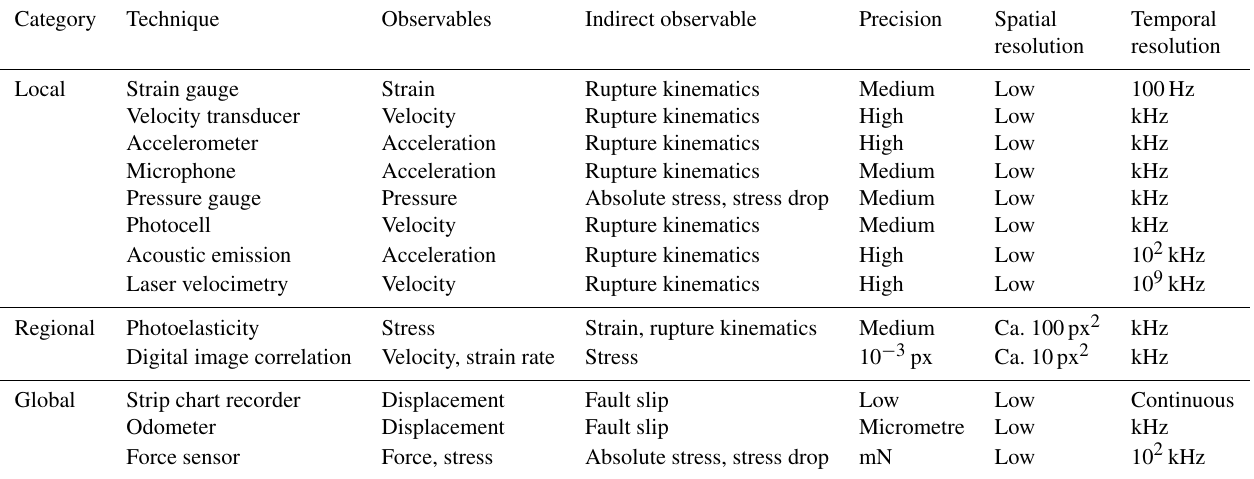
Table 5. Monitoring techniques used in analogue earthquake models (see text for discussion). Category Technique